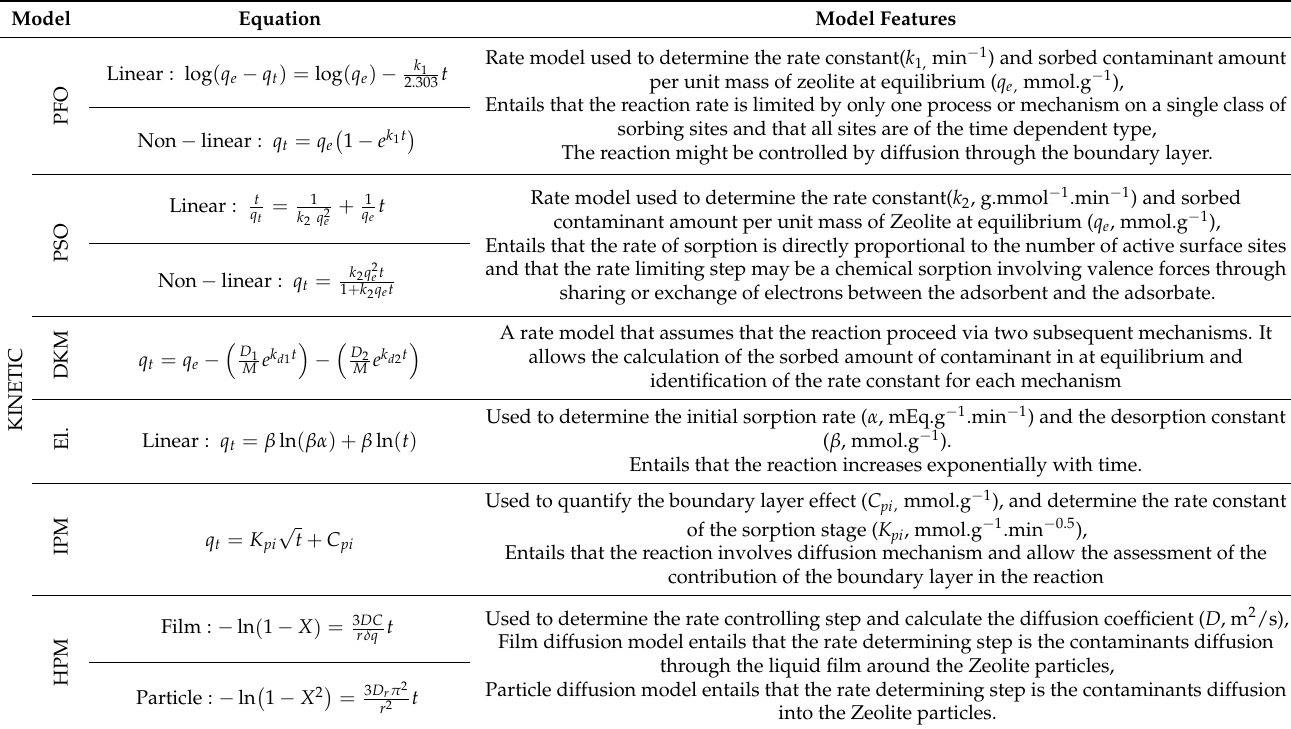
Table 3. Models used in analyzing the results of batch investigations for ion-exchanger/sorbents. Model Equation Model